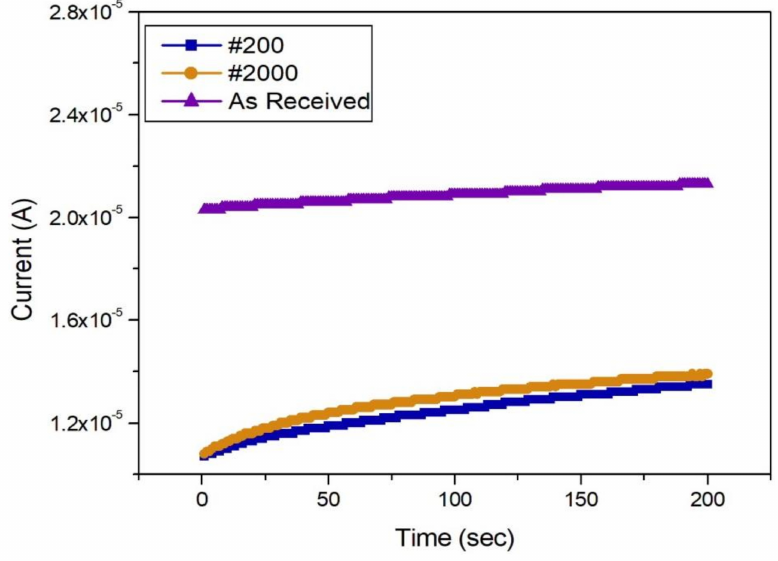
Figure 6. Graph of galvanic corrosion results at all SPCC surface conditions for #200